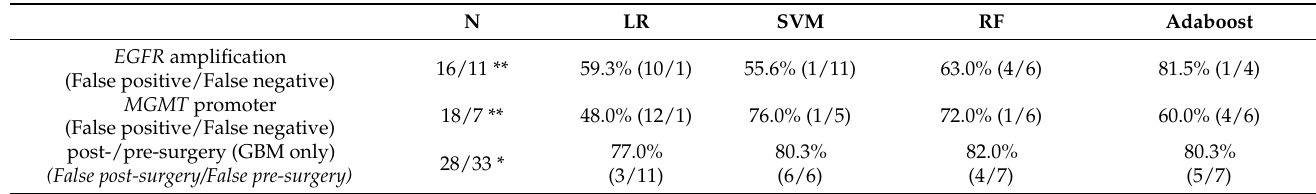
Table 2. Best obtained accuracy with the different machine learning